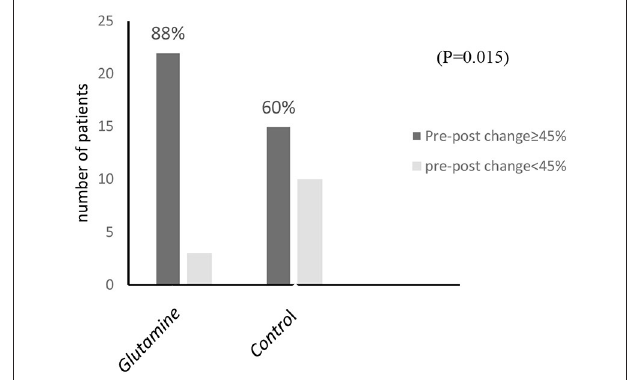
FIGURE 2 | The number of patients in both glutamine and control groups at the end of the study based on the percentage of change in IBS severity score.